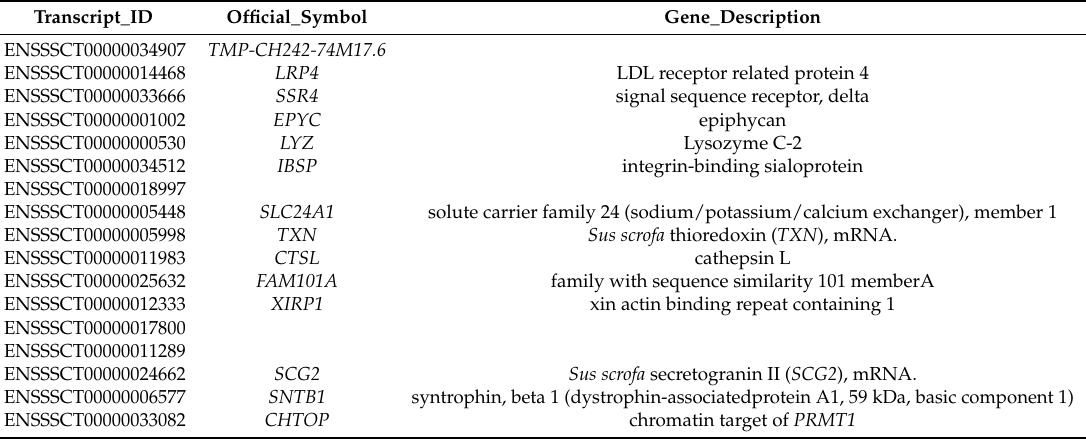
Table 1. Seventeen differentially expressed transcripts common to all three